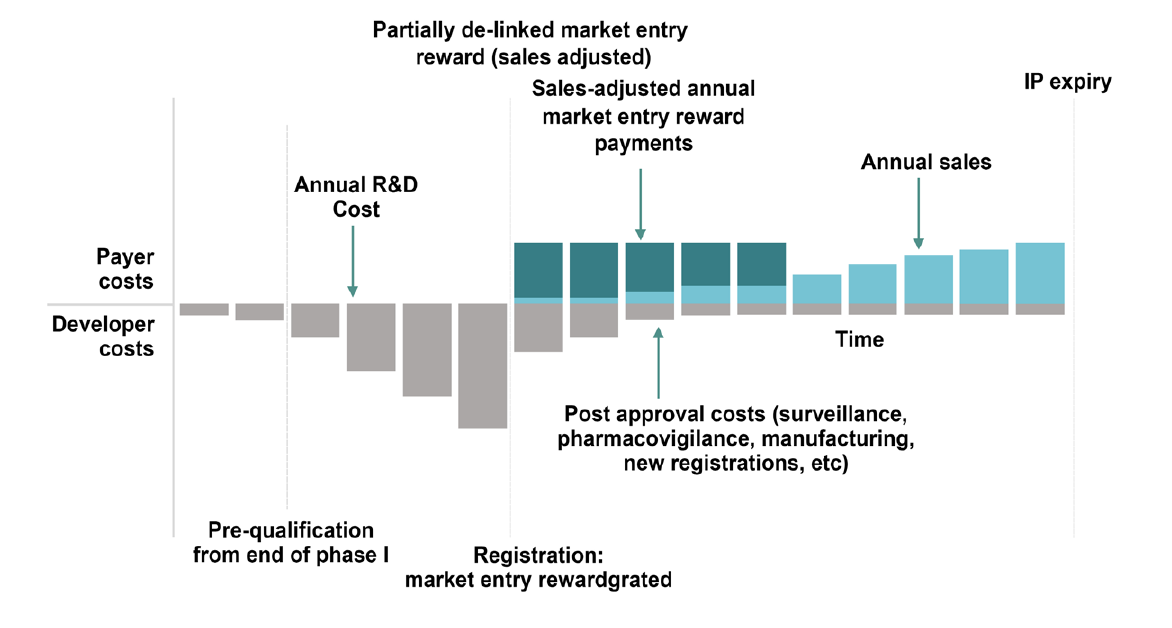
Figure 5. A partially de-linked market entry reward model [ 92